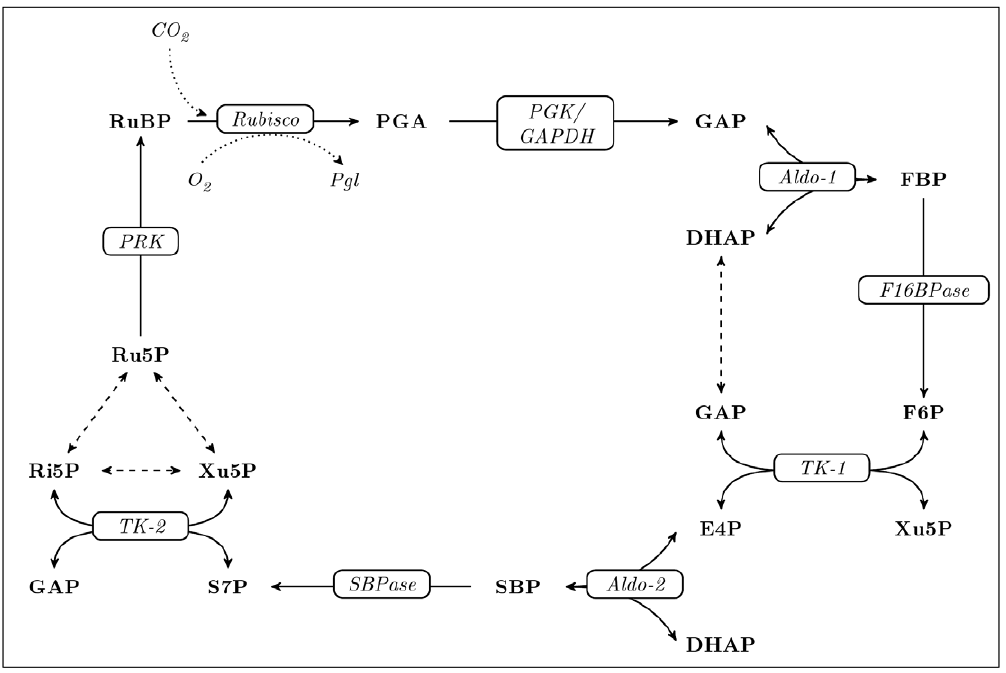
Figure 5. Isolated CBC subnetwork. Isolated subnetwork after restriction to metabolites which are exclusively used by the CBC. Compounds written in italics represent external substances the concentrations of which are kept constant in the model. Dotted lines indicate the reactions of cofactors. Metabolites connected by dashed lines are assumed to be in equilibrium.